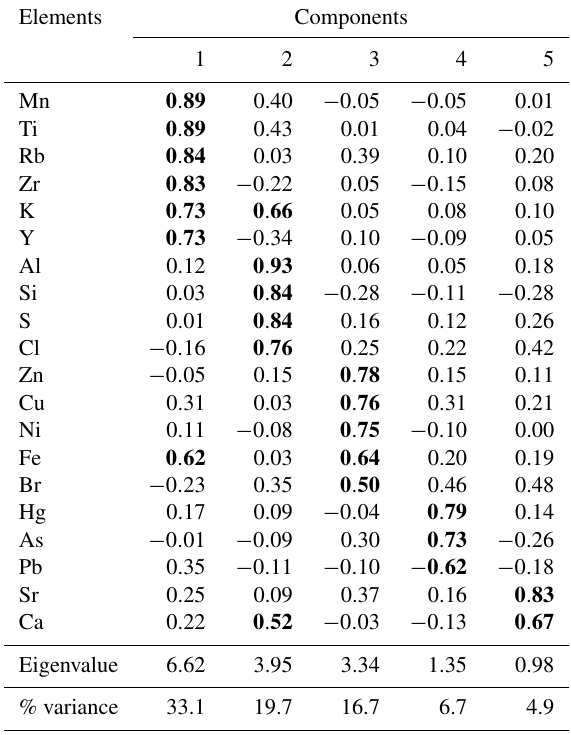
Table 1. Factor loadings for the five significant components ex- tracted by PCA from Adélie Basin sediment samples. Component loadings ≥ 0 . 5 are in